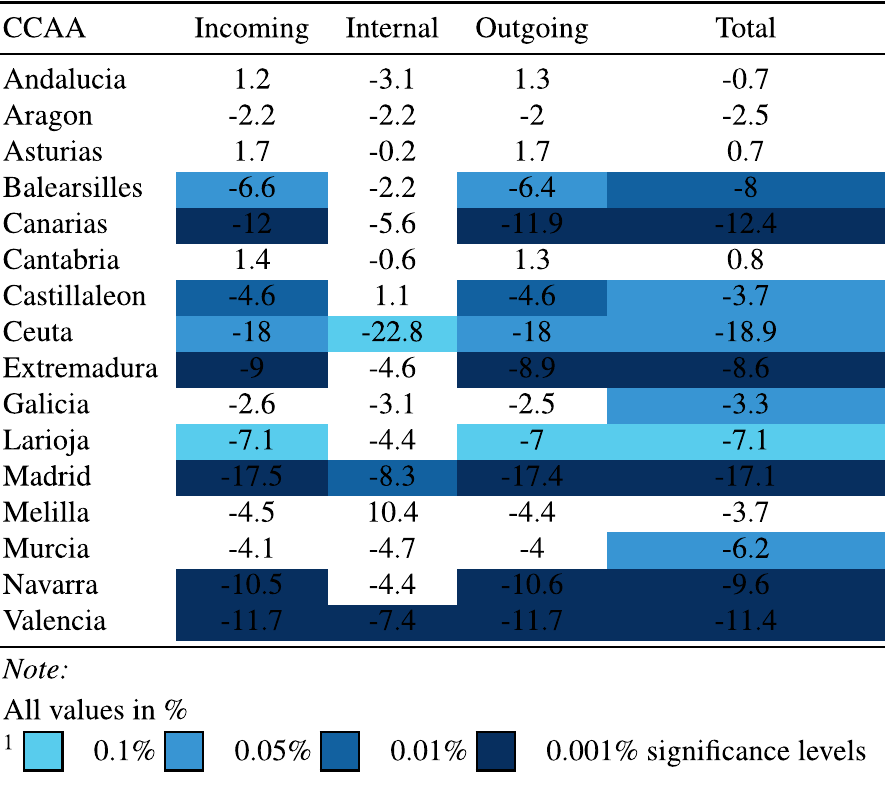
Table 5. Diff-in-diff estimates for mobility type: the mobility types incoming and outgoing appear correlated with all of the coefficients being similar to each other. Since these two mobility types are correlated, the total is also somewhat correlated. The CCAAs whose coefficients were statistically significant at the 0.1% level ranged between − 9 and − 17.5% and between − 8.9 and − 17.4% for incoming and outgoing respectively suggesting that the policy reduced mobility anywhere between − 9 and − 17.5% depending on the control group used. Total mobility at the same significance level ranged from − 8.6 to − 17.1%. These findings indicate that the policy had a real and direct effect on reducing the movement of people across MITMA